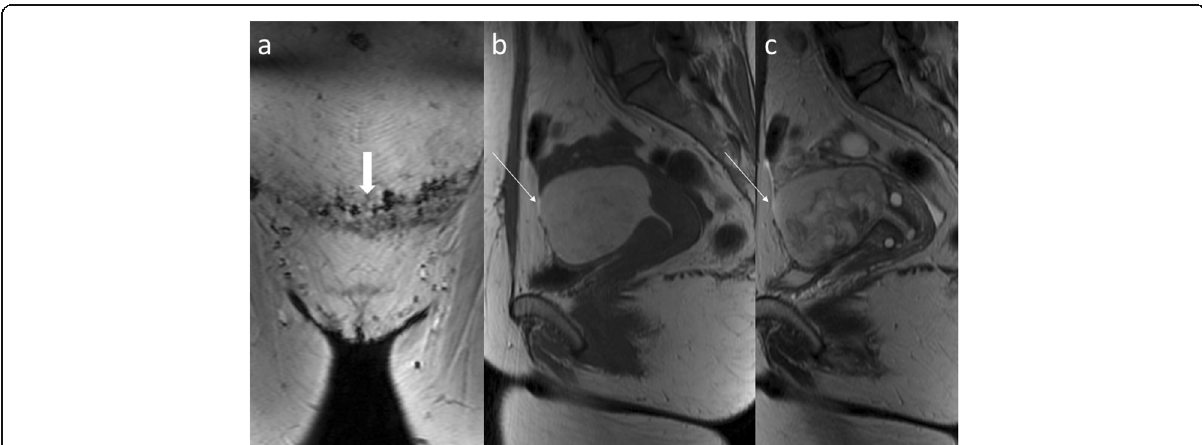
Fig. 7 Pelvic MRI. A 42-year-old woman with a history of three C-sections. a GRE/T2*WI in the coronal plane (skin scar is shown by a thick arrow). b FSE/T1WI and c FSE/T2WI, both in the sagittal plane, depict a huge blood reservoir (T1-hyperintense, of mixed signal intensity on T2WI) with no serosal layer (no hypointense line) on the outer surface (thin white arrows). In pathology report: adenomyosis with autoamputation of the uterine body